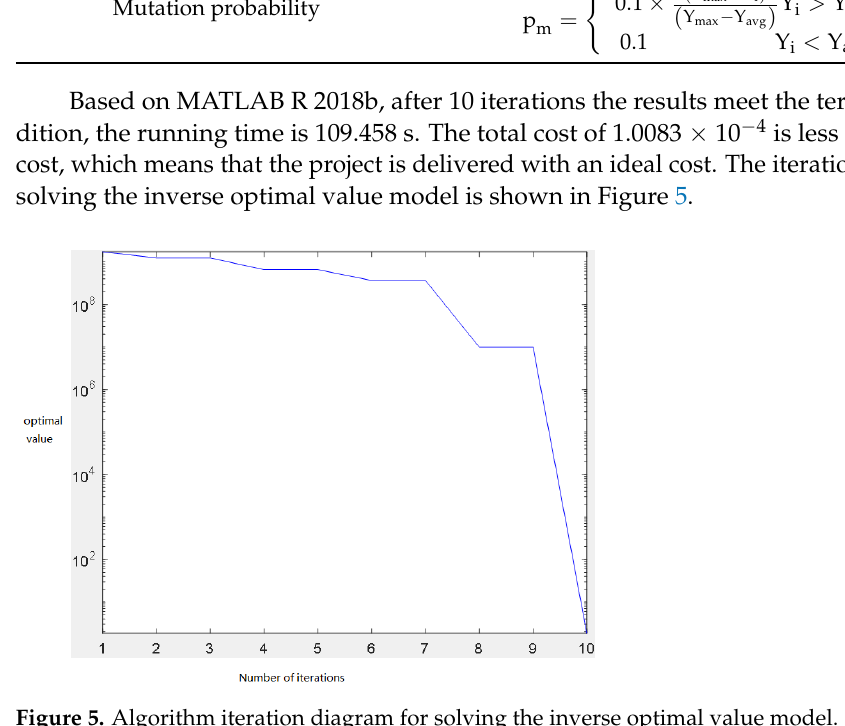
Figure 5. Algorithm iteration diagram for solving the inverse optimal value model.